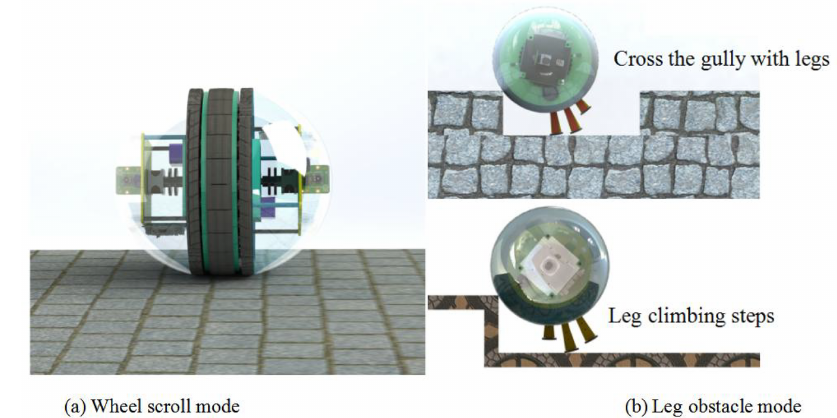
Figure 3. Motion mode of wheel leg deformation mechanism.